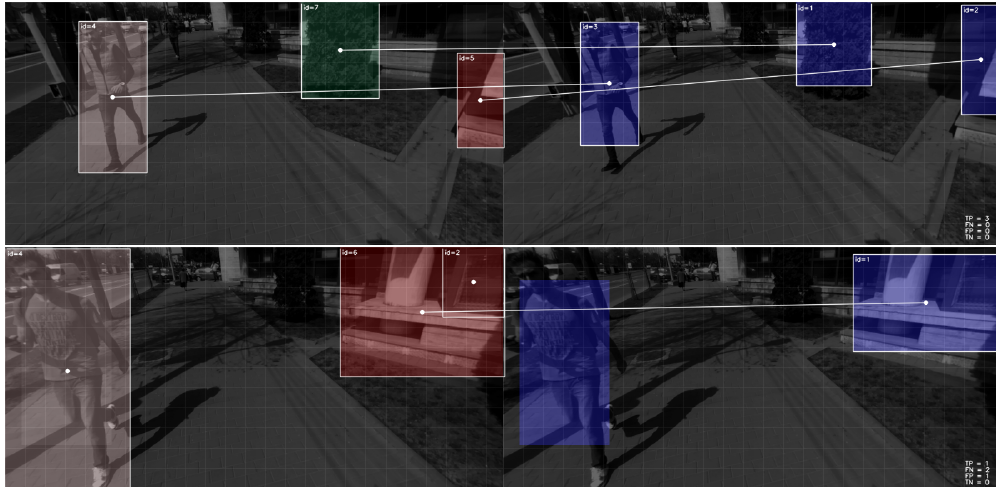
Figure 7. Examples of automatically established correspondences between detected elements ( right ) and ground truth ( left ) for evaluation purposes. Top image shows correct identification of correspondences based on a 0.5 value for the similarity coefficient. The bottom image is an example of a frame for which a manual refinement of the correspondences was performed to account for the missing correspondence in the case of the pedestrian and to account for the clustering of the building elements into a single